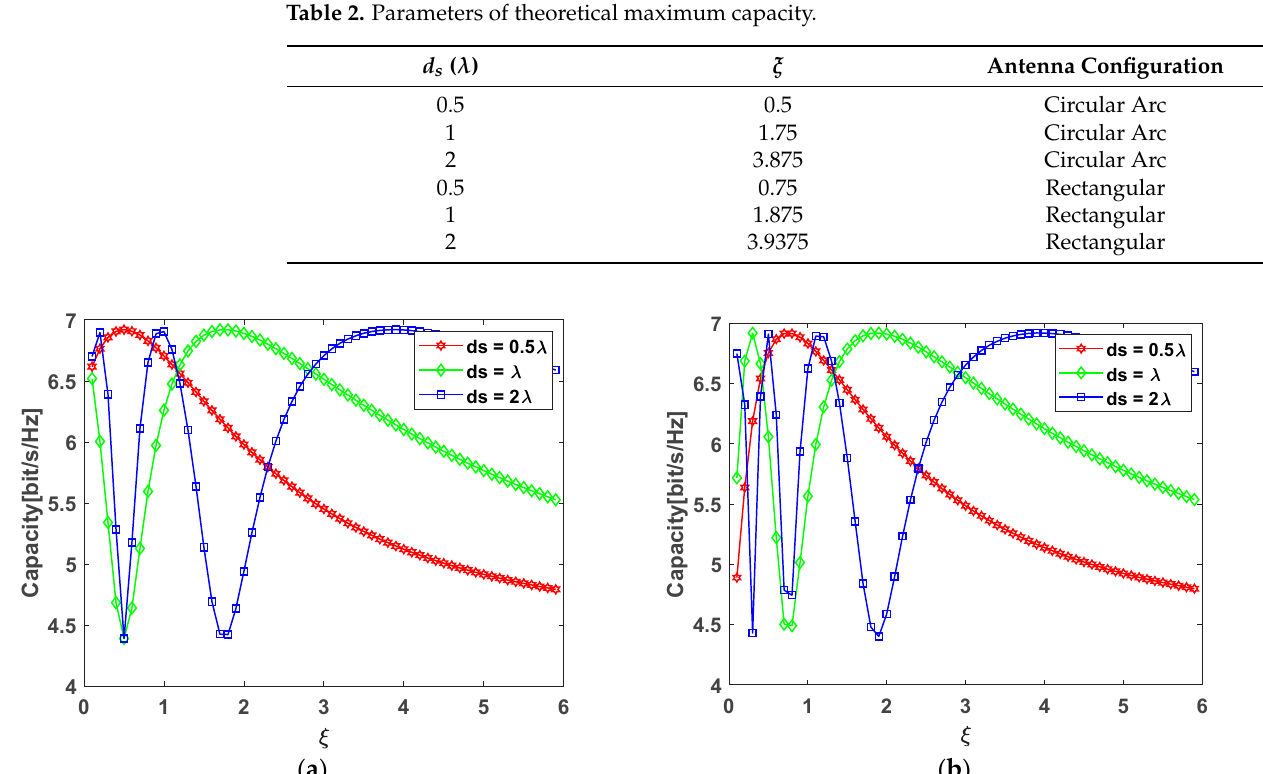
Figure 8. Channel capacity under two different 2 × 2 antenna configurations: ( a ) circular arc antenna array; ( b ) rectangular antenna array.